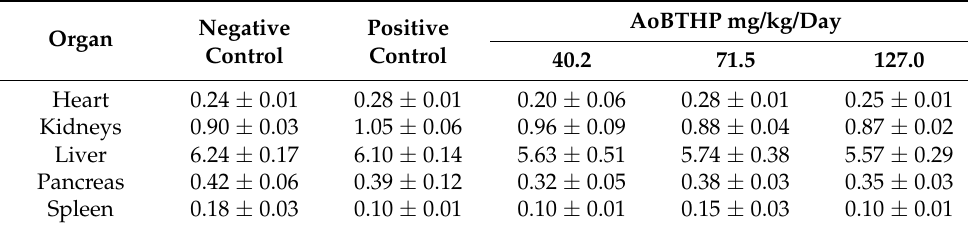
Table 6. Relative organ weights collected for each group of animals sacrificed—percentage g/g of body weight (mean ±